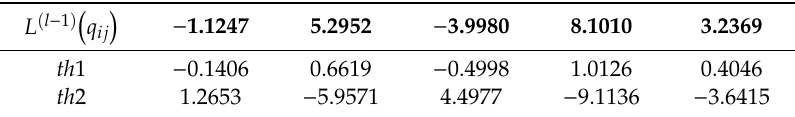
Table 4. Some values of th 1 and th